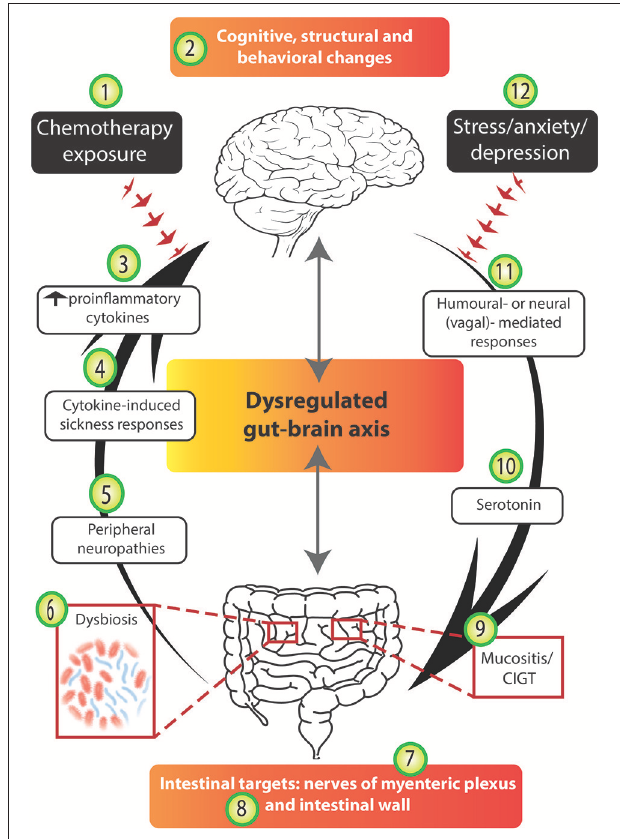
FIGURE 4 | Chemotherapy disrupts several stages of the gut-brain axis. The arrows highlight the bidirectional nature of the gut-brain axis; in an unbalanced system mechanisms from the bottom-up (and vice versa) are disrupted. We suggest that chemotherapy-induced gut-brain axis dysregulation plays a major role in the intestinal, psychological and neurological complications experienced by many cancer patients. Chemotherapy exposure (1) often results in molecular and structural changes in the brain (2), e.g., hippocampal changes as identified in rodent models. Chemotherapy exposure causes cognitive and behavioral changes (2) to a subset of patients and these findings have been supported by some experimental models. The altered immune profile of chemotherapy recipients results in increased circulating pro-inflammatory cytokines (3) which have been reported to cause cytokine-induced sickness-like responses (4) which mimic chemotherapy-induced side-effects. Damage to peripheral nerves resulting in peripheral neuropathies (5) are experienced by some chemotherapy recipients. Chemotherapy targets the intestines and its microbial contents causing dysbiosis (6), impairing the nerves of the myenteric plexus (7), damaging intestinal wall parameters (8), and resulting in mucositis (9). Serotonin dysregulation under chemotherapy conditions (10) may play a role in chemotherapy-induced intestinal and neurological changes. Finally, both humoral and neural/vagal peripheral-to-central immune signaling pathways (11) may mediate chemotherapy-induced gut-brain axis dysregulation. Importantly, we acknowledge that the stress, anxiety and depression associated with cancer diagnosis and treatment (12) may contribute to both bottom-up and top-down pathways, having negative effects in the gut and the